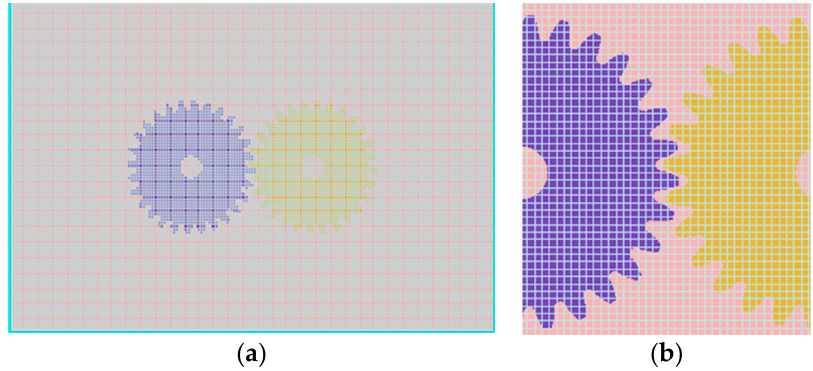
Figure 2. Mesh. ( a ) Entire mesh; and ( b ) enlarged view of mesh around gears.